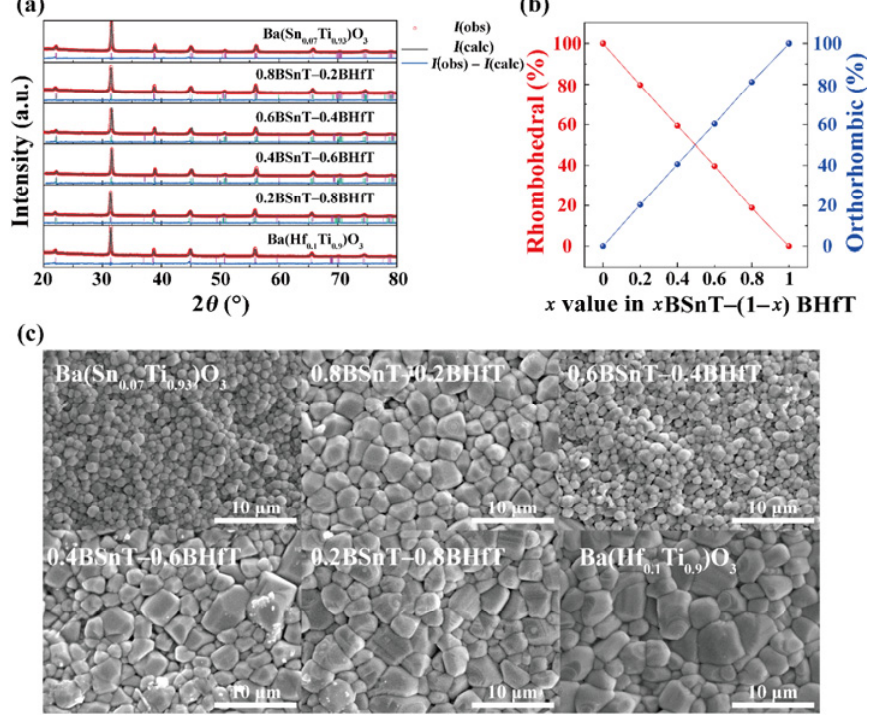
Fig. 1 (a) XRD patterns of x BSnT–(1 − x )BHfT ceramics. (b) Phase fractions of orthorhombic phase (blue line) and rhombohedral phase (red line) related to different compositions. (c) Surface morphology images of x BSnT–(1 − x )BHfT ceramics with various x